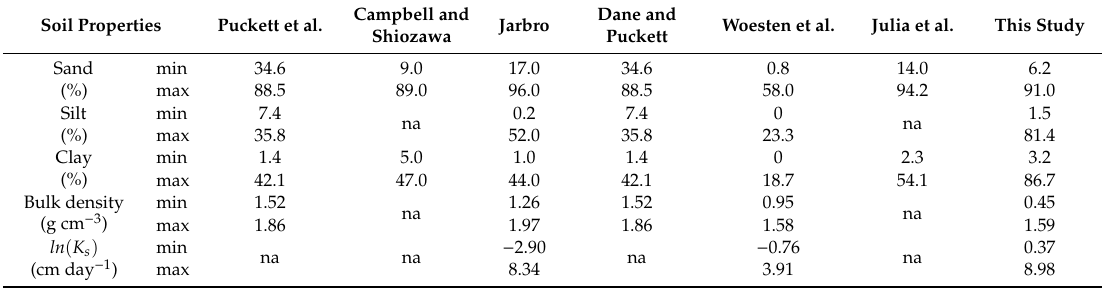
Table 4. Brief descriptive statistics for soil properties in previous